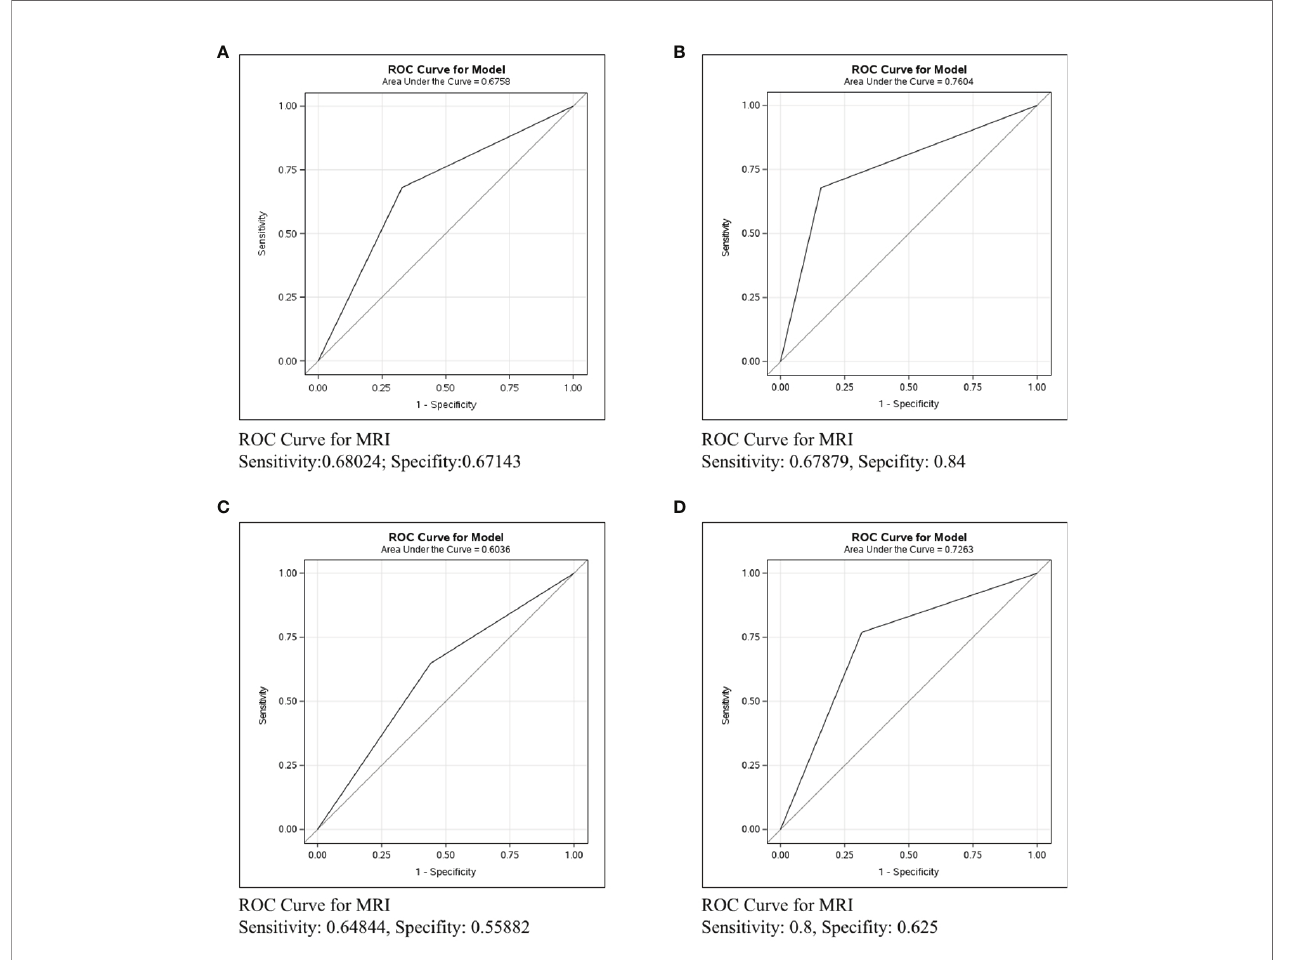
FIGURE 7 | ROC curve analysis for MRI in all molecular subtypes. The vertical axis is sensitivity, the horizontal axis is 1-speci fi city. AUC is a parameter used to measure the value of MRI in the prediction of axillary lymph nodes. (A) ROC curve in all molecular subtypes. (B) ROC curve in ER/PR+Her2- subtype. (C) ROC curve in Her2+ subtype. (D) ROC curve in ER/PR-Her2-